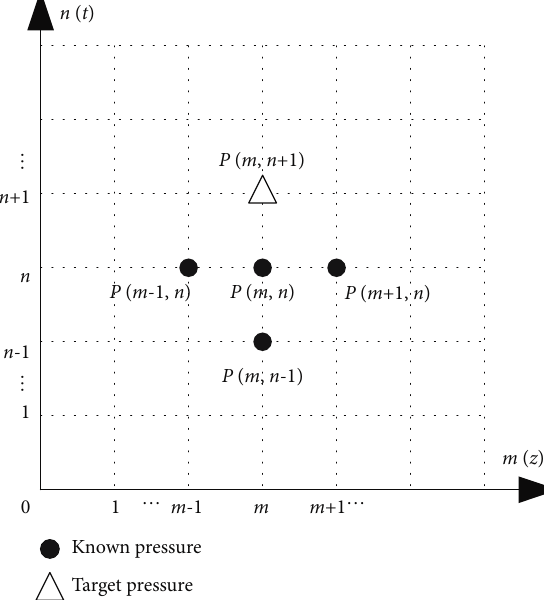
Figure 1: The grid of the recursive process in the wavenumber- time domain.